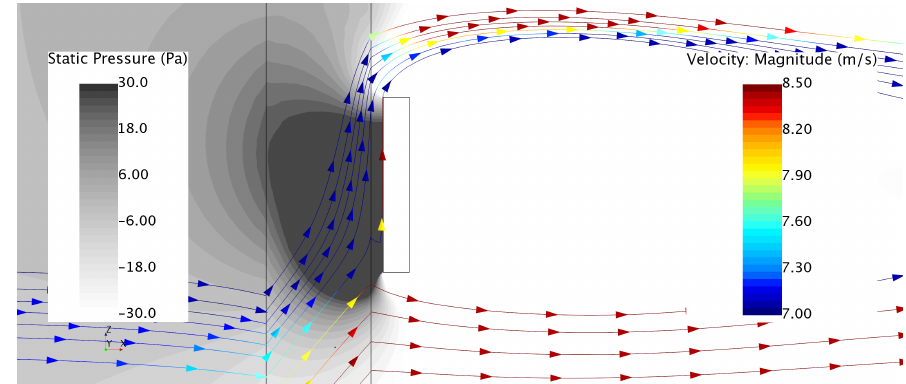
Figure 12. Static pressure field and constrained streamlines of relative velocity coloured by velocity